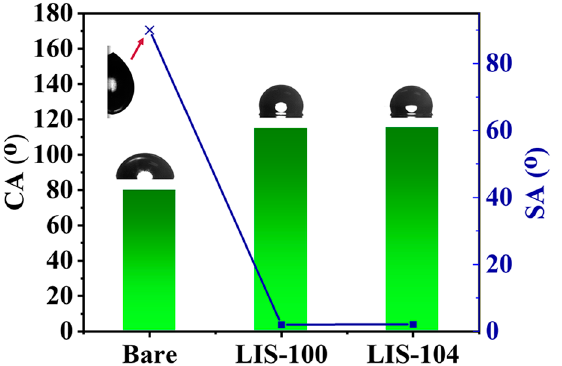
Figure 2. Wettability of bare, LIS-100 and